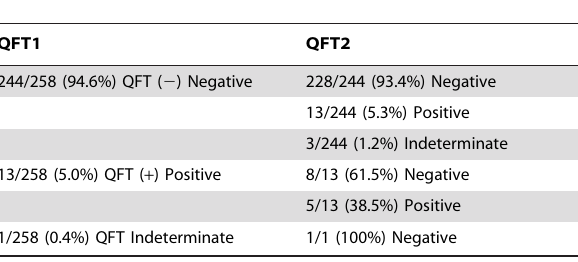
Table 5. Dichotomous QFT results at time 1 and time 2. Table 6. 1 year QFT pattern stratified by TST1 and QFT1